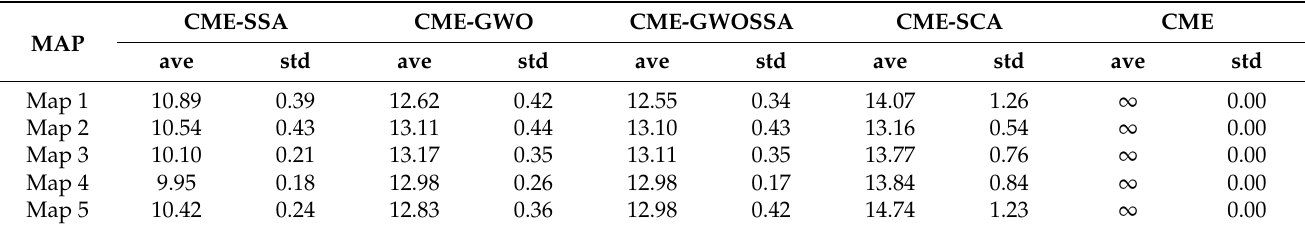
Table 6. Time consumptions results of algorithms in the complex environment.